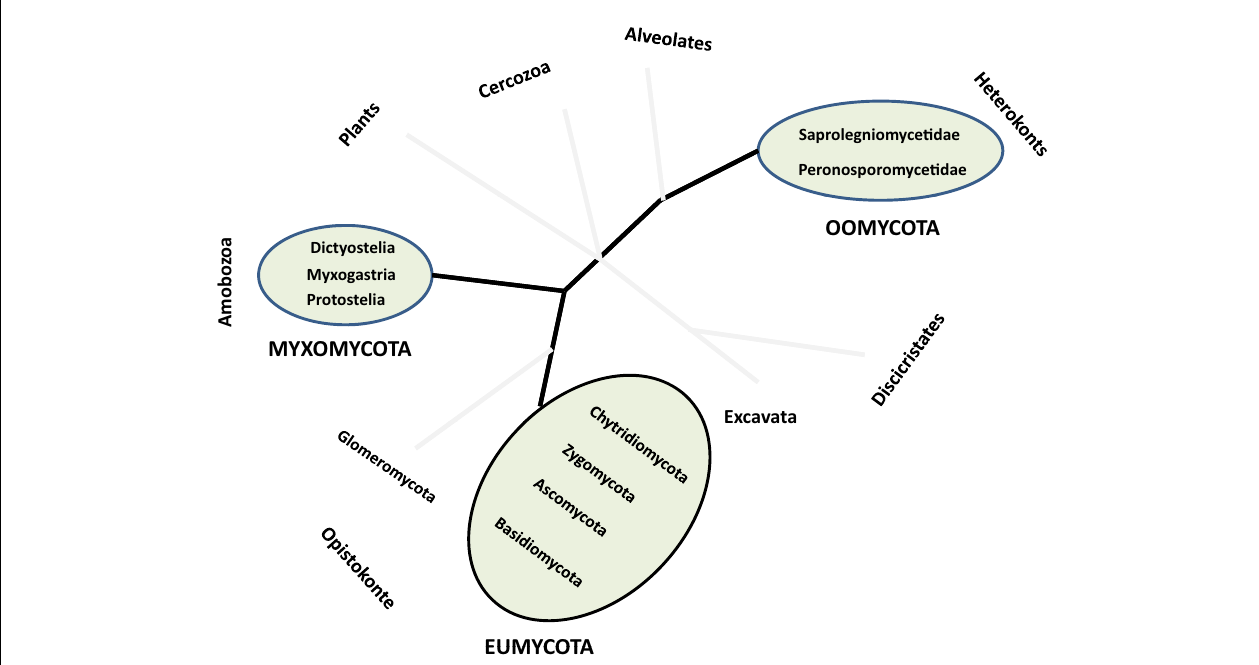
FIGURE 1 |Approximate position of true-Fungi (Eumycota) and fungus-like (Oomycota and Myxomycota) organisms in a schematic phylogenetic tree of eukaryotes. Modified from Jobard et al.